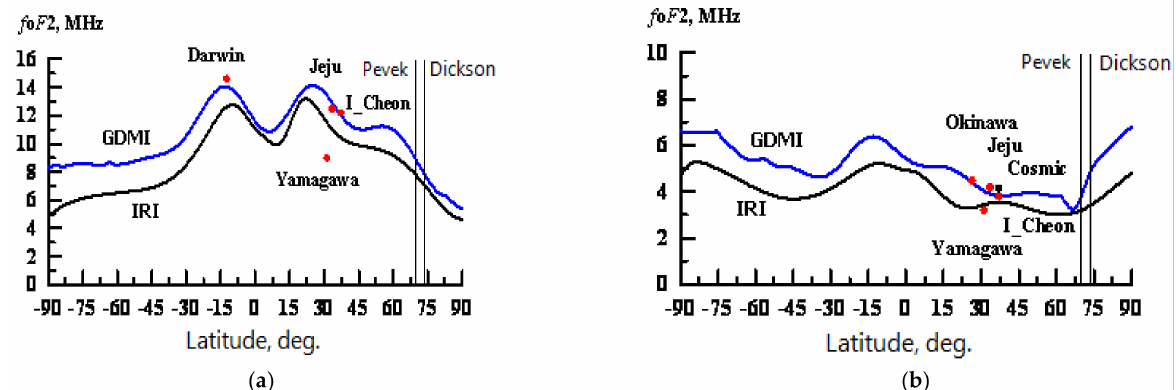
Figure 1. Latitude dependence of foF2 at 128 ◦ longitude (Tiksi) under quiet geomagnetic conditions on 13 February 2014, in two models: ( a ) the near-equatorial anomaly in local daytime (12.5 LT) and ( b ) the main ionospheric trough at nighttime at 68 ◦ latitude (04.5 LT). The dots mark the VIS data for foF2 on the observatories located near this